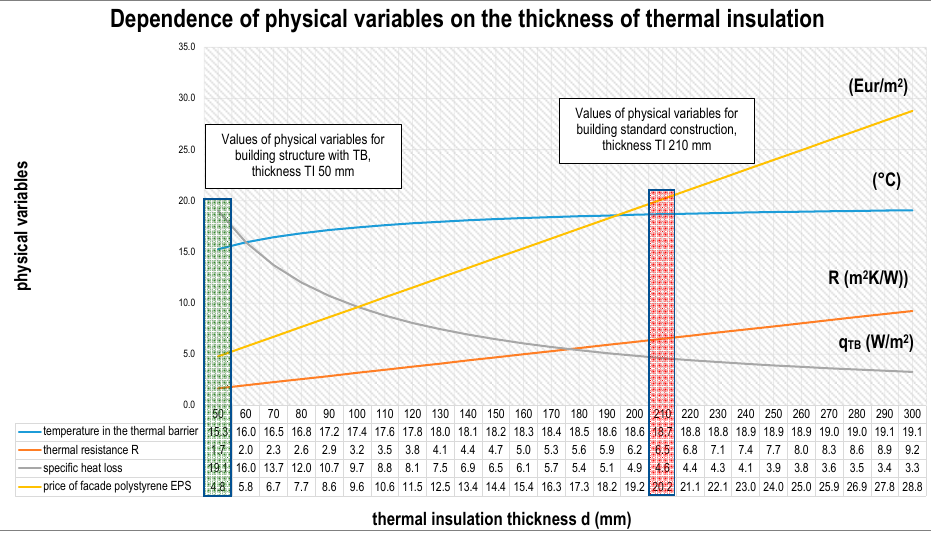
Figure 10. Dependence of physical variables on the thickness of thermal insulation.